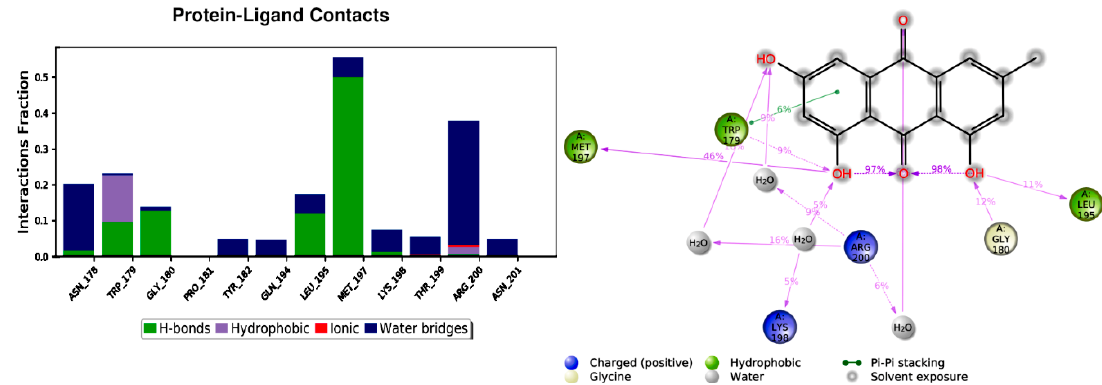
Figure 4. RMSD of emodin pose in site 1 ( A ), site 2 ( B ), and site 3 ( C ). The left Y axis is for protein RMSD, and the right scale is for ligand RMSD. How stable a ligand is in relation to a protein and its binding pocket is shown by the ligand RMSD (right Y-axis). Red for the protein backbone and blue for the ligand RMSD. MD simulations time in ns (X-axis).